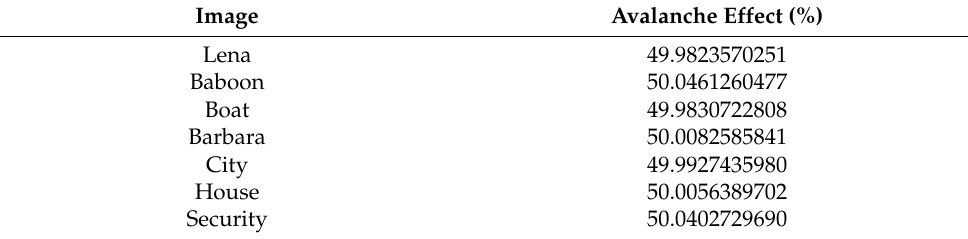
Table 9. Avalanche effect